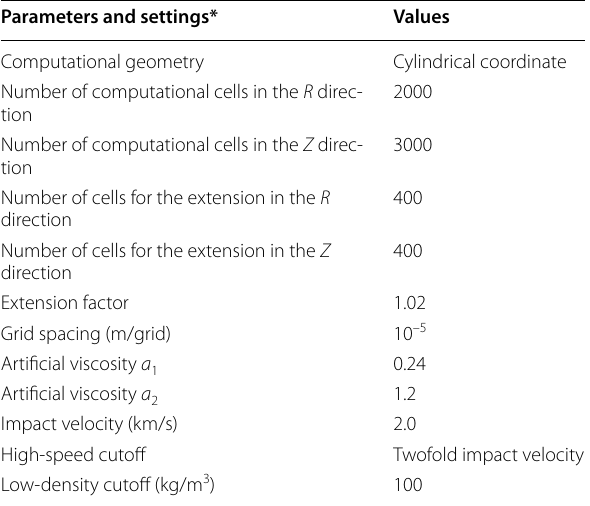
Figs. 1a, b, and d, respectively. The diameter and height of all the projectiles were set to 3.2 mm. To simulate the impact of projectiles having a similar bulk density, the thicknesses of the closed and open tubes were set to 0.20 and 0.25 mm, respectively, resulting in the bulk densities of the closed and open tubes being 2.53 and 2.58 g/cm 3 , respectively.